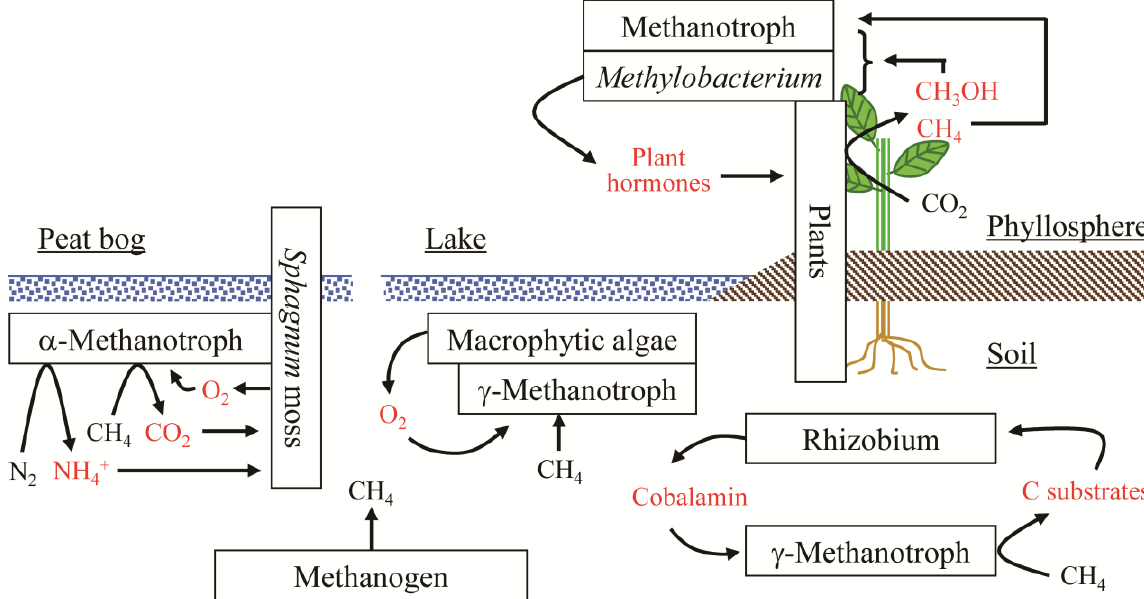
Figure 2. Positive relationships of methylotrophs. In the phyllosphere, C1 compounds generated by plants allow methanol-utilizing methylotrophs (e.g., Methylobacterium species) and methanotrophs to populate. In aquatic environments, methanotrophs belonging to γ- and α- Proteobacteria dominantly colonize on macrophytic algae and Sphagnum mosses, respectively, which supply O 2 for methane oxidation by the methanotrophs. In several environments including soils, growth of some γ-proteobacterial methanotrophs require cobalamin supplied from heterotrophic bacteria such as rhizobial